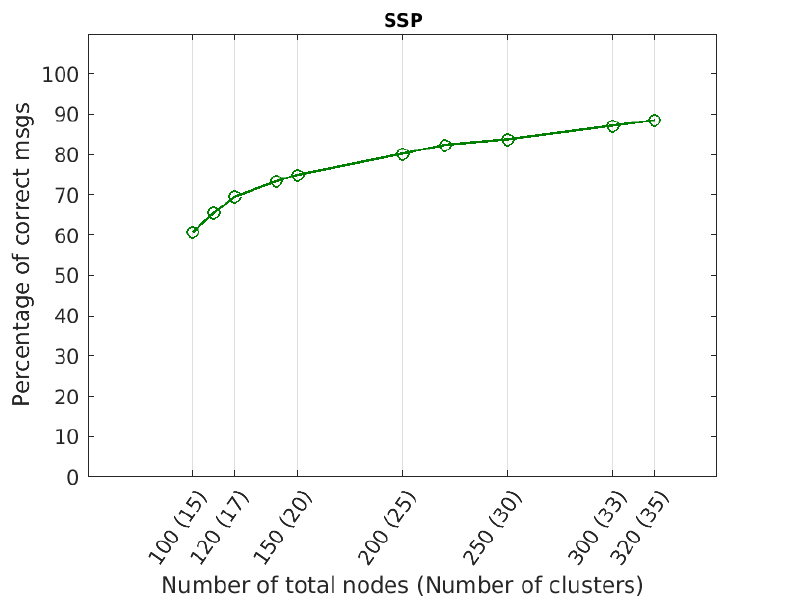
Figure 9. The network